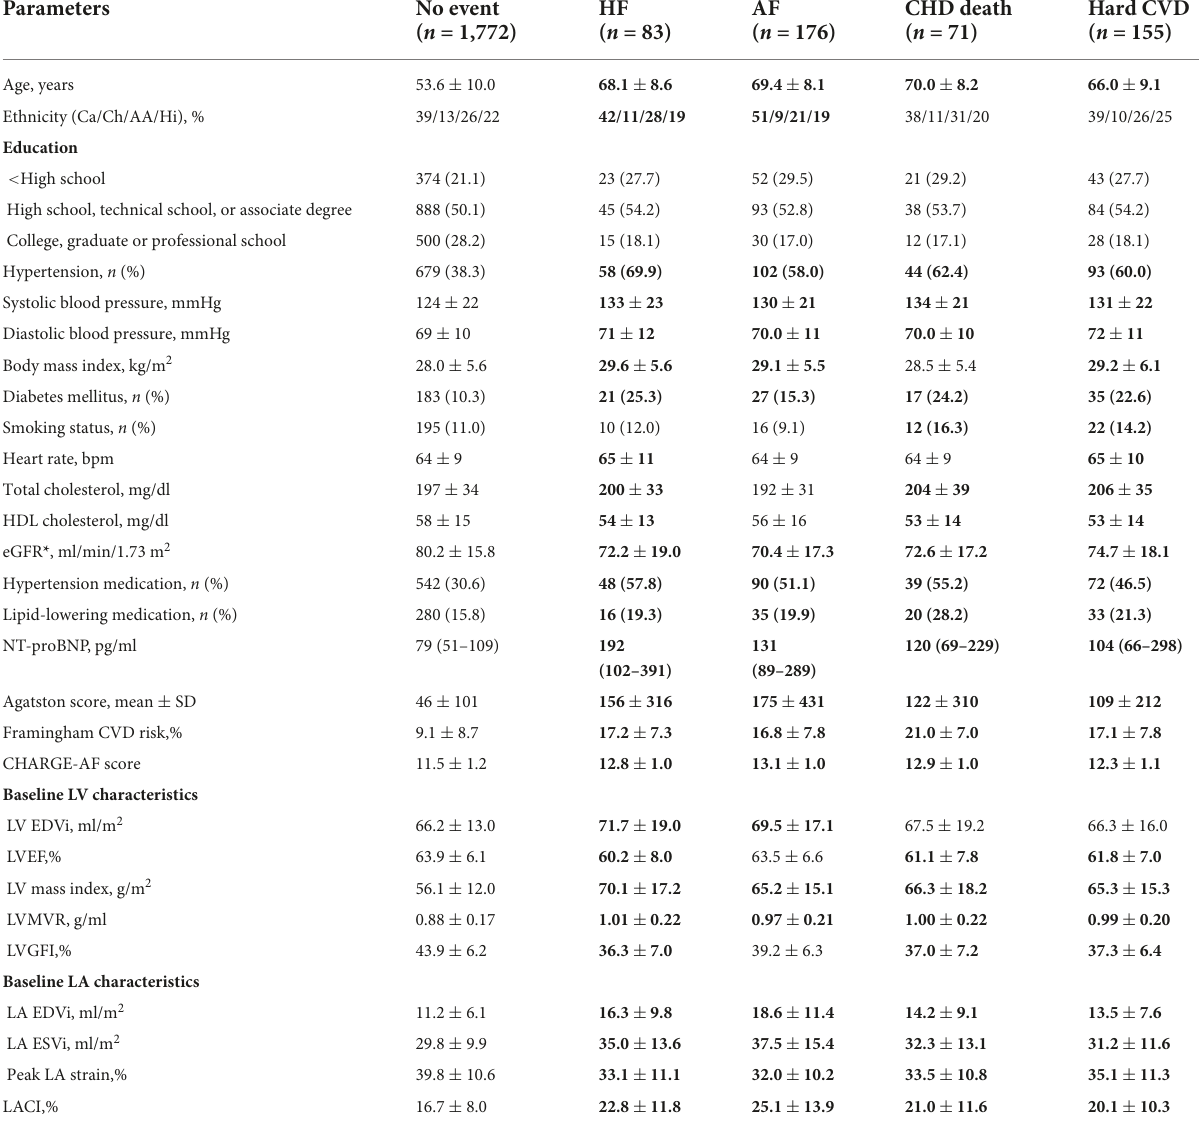
TABLE 1 Population characteristics of participants at baseline before occurrence of events by incident event categories ( n = 2,087).